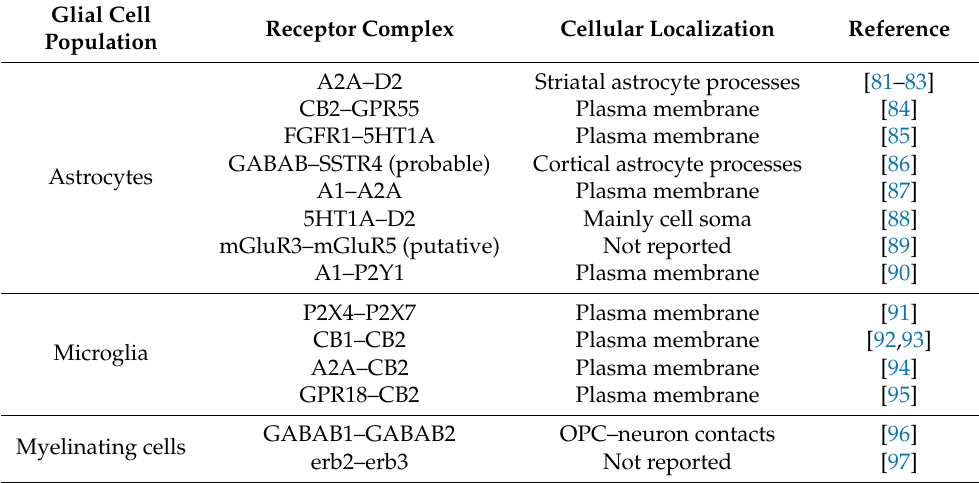
Table 1. Receptor complexes identified in glial cell